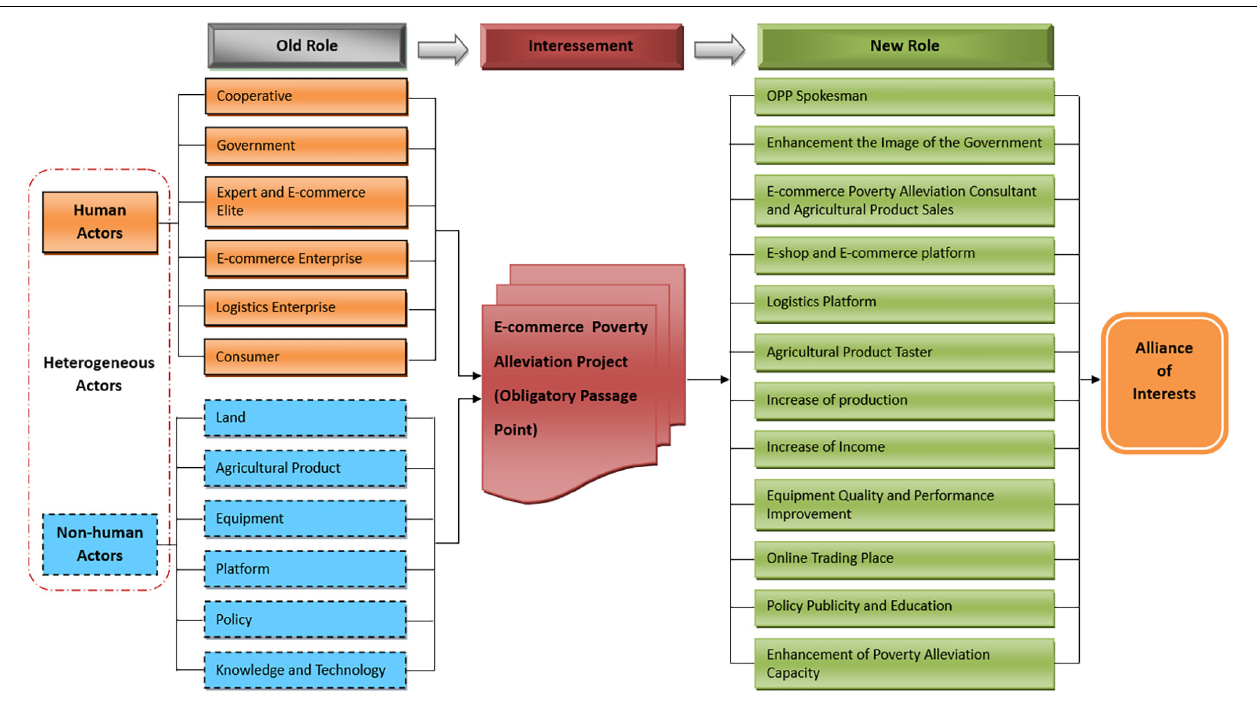
FIGURE 4 | The interessement of